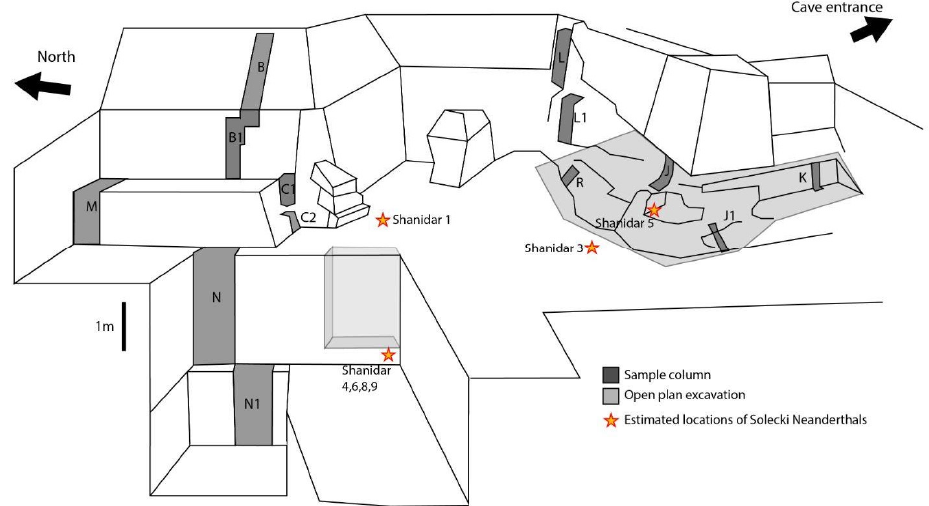
Figure 2. Schematic of recent excavations showing the locations of the sample columns and open- plan excavation areas. The northern sequence combines samples from Sample Columns B, B1, M, N, and N1 and the lower open-plan excavation area. SH19GS samples all come from the lower open- plan excavation area, shown in the figure as the lower light-grey rectangle. The southern sequence combines samples from Sample Columns L, L1, J, J1, and R and the upper open-plan excavation area. SH18GS samples all come from the upper open-plan excavation area, shown in the figure as the upper light-grey area. Diagram created by E. Hill.